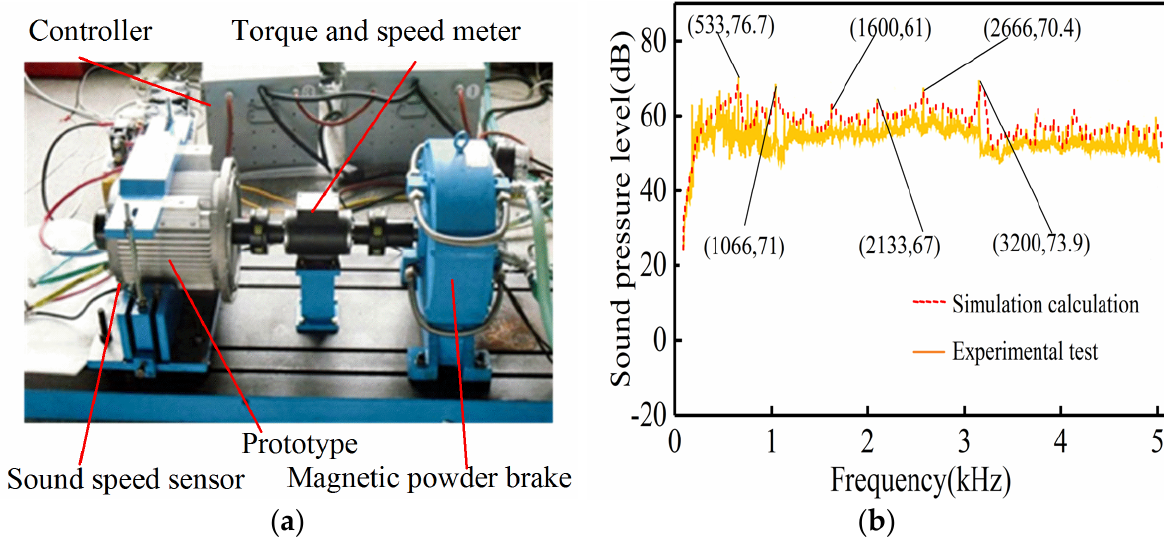
Figure 10. ( a ) Field test diagram of noise of FeCo-based motor; ( b ) comparison between SPL spectrum simulation and experimental test.